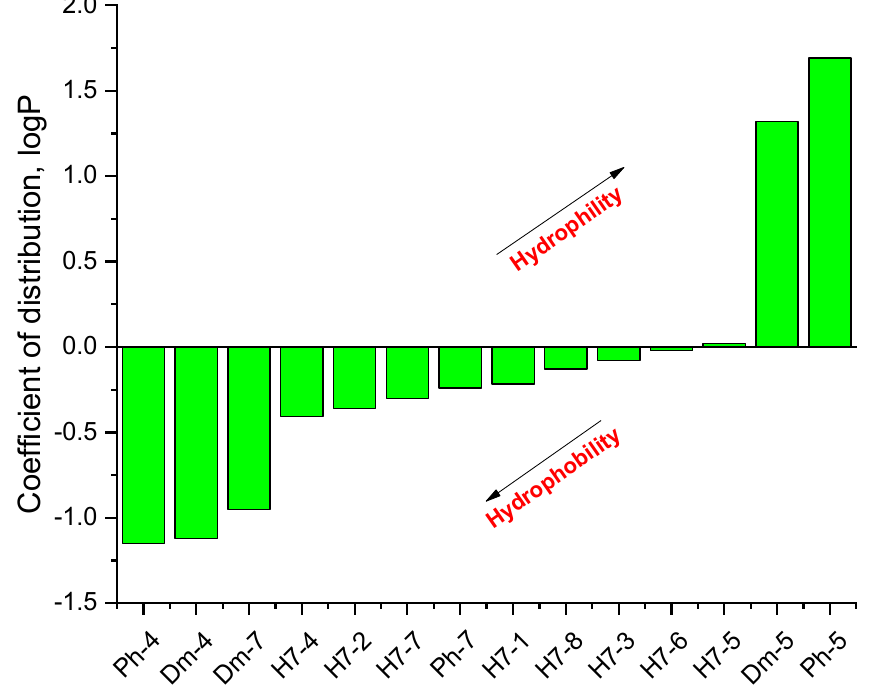
Figure 5. Logarithmic values of the partition coefficient (log P) of some of the investigated hemorphin compounds.